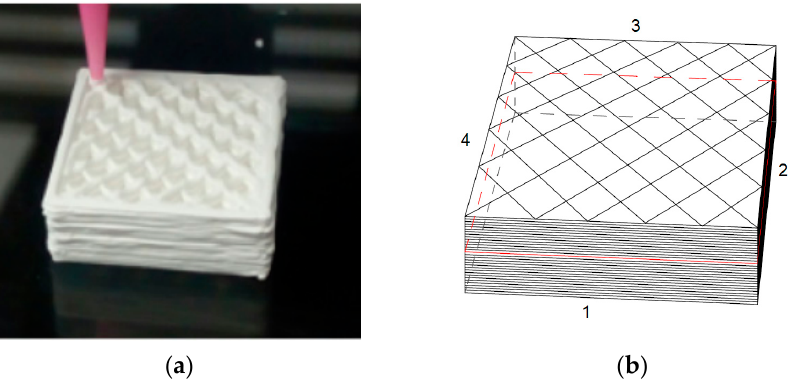
Figure 1. An example of a printed specimen: ( a ) picture; ( b )